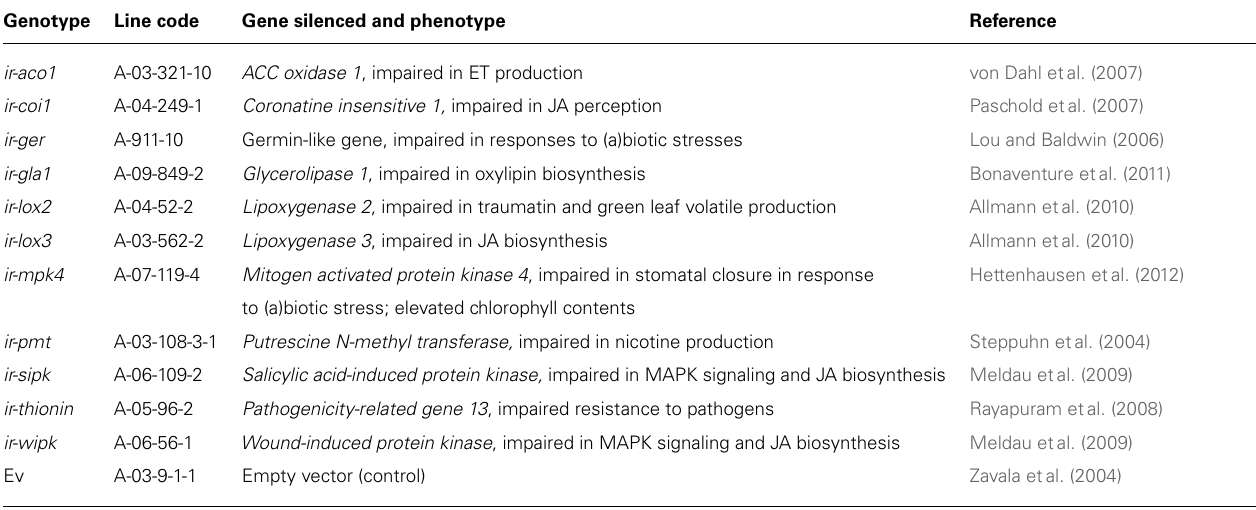
Table 2 | Nicotiana attenuata lines used in Figure